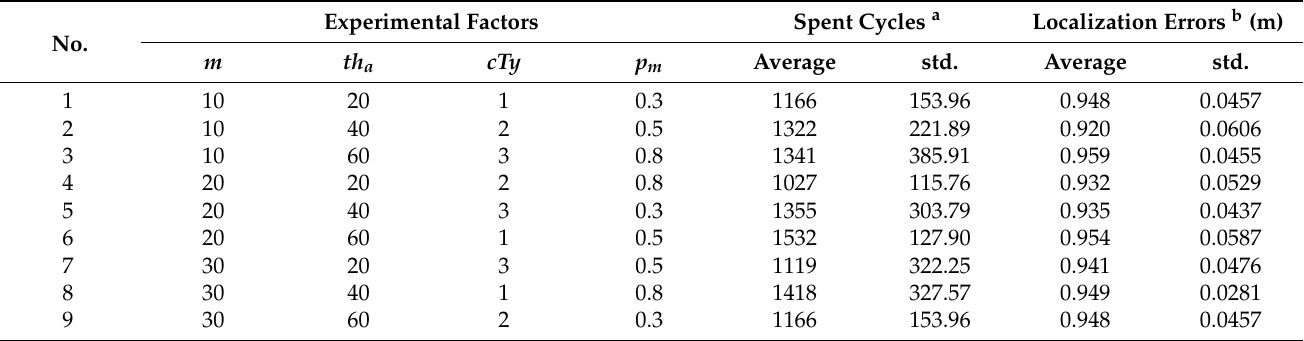
Table 3. Orthogonal experimental results of different m , th a , cTy , and p m in uGA.